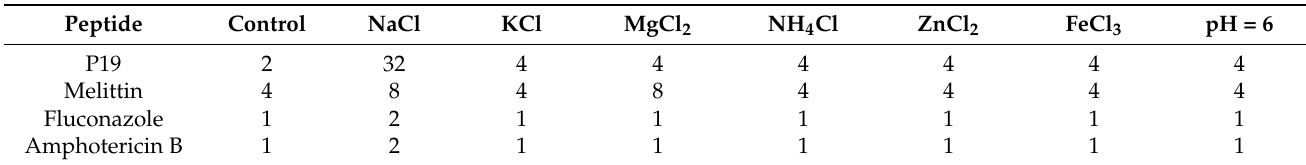
Table 4. The MIC values of the peptides against C.albicans cgmcc 2.2086 in the presence of physiological salts and acid 185 environment.